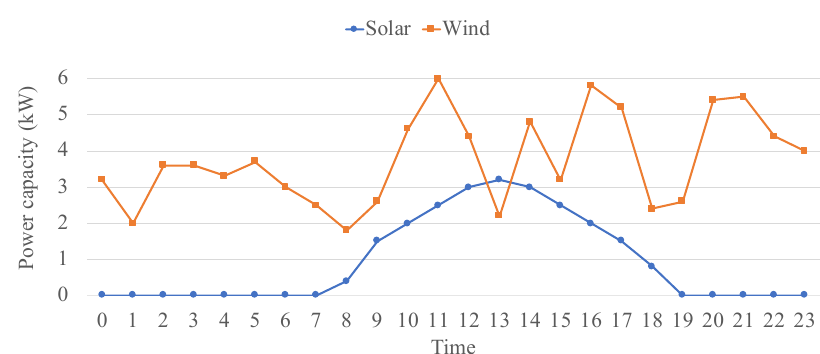
Figure 17. Generation of power in practical sources for solar and wind